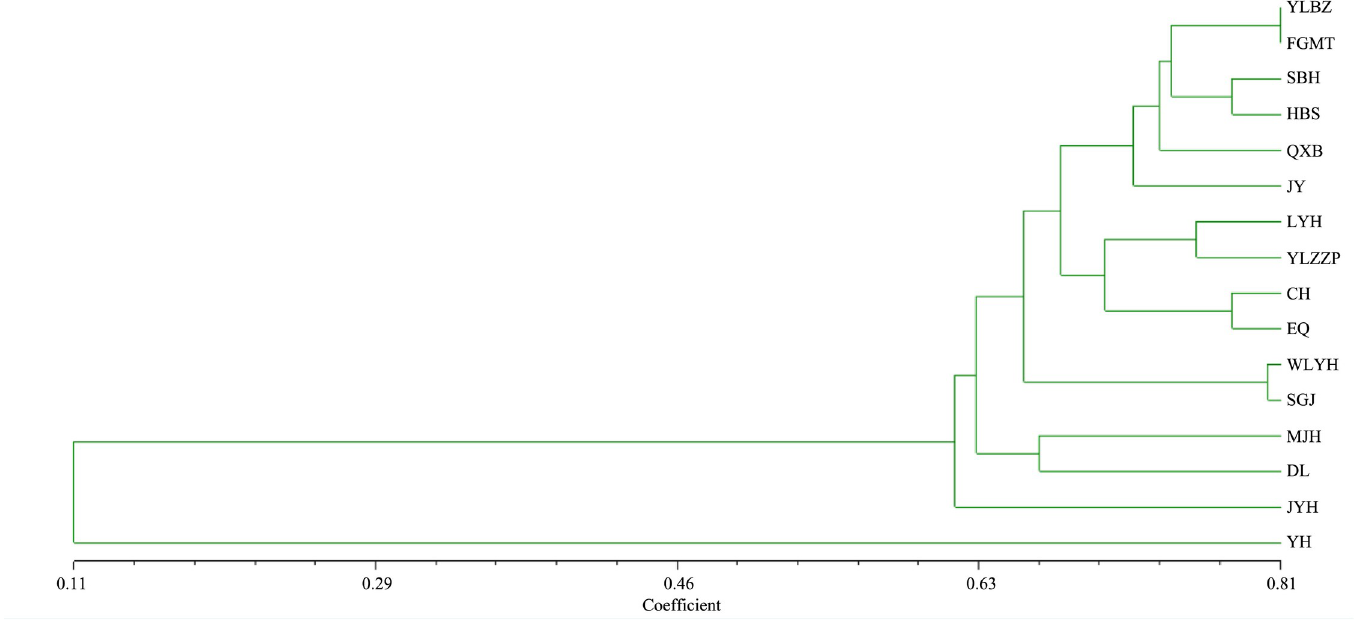
Fig 6. Dendrogram of 16 peony species revealed by the cluster analysis of the genetic similarity estimates generated by Nei coefficient based on 45 SSR markers.